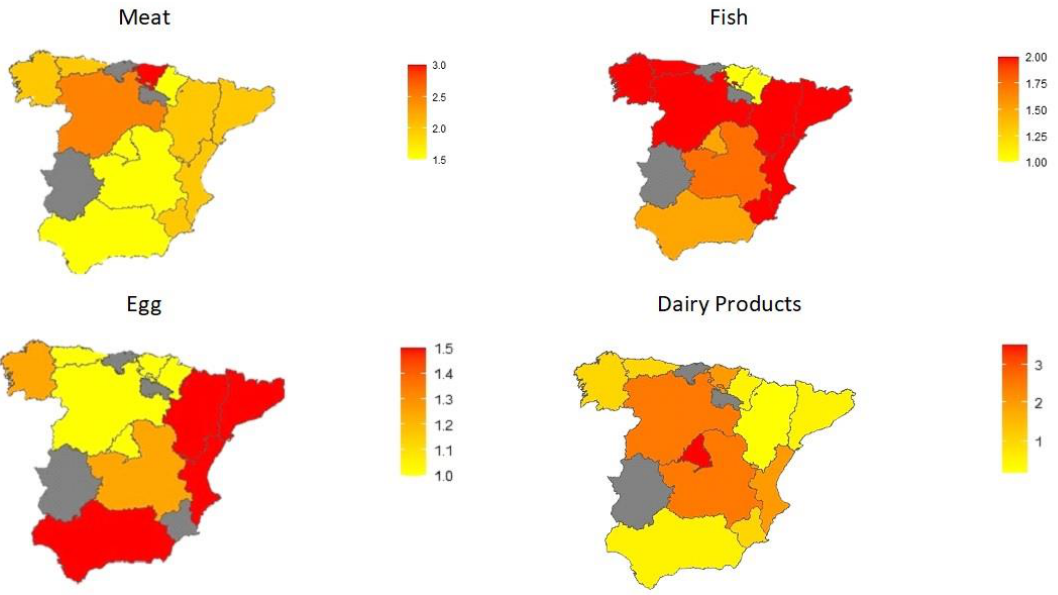
Figure 1. Frequency of the weekly provision of recommended food groups as suggested by Auton- omous Communities (CCAAs) in food guides for school food services in